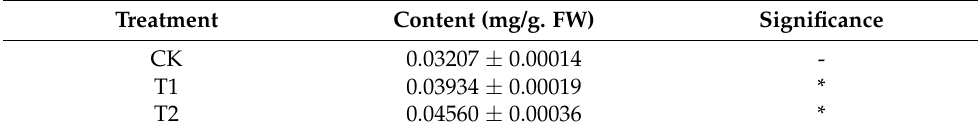
Table 2. Quantitative determination of α -linolenic acid.